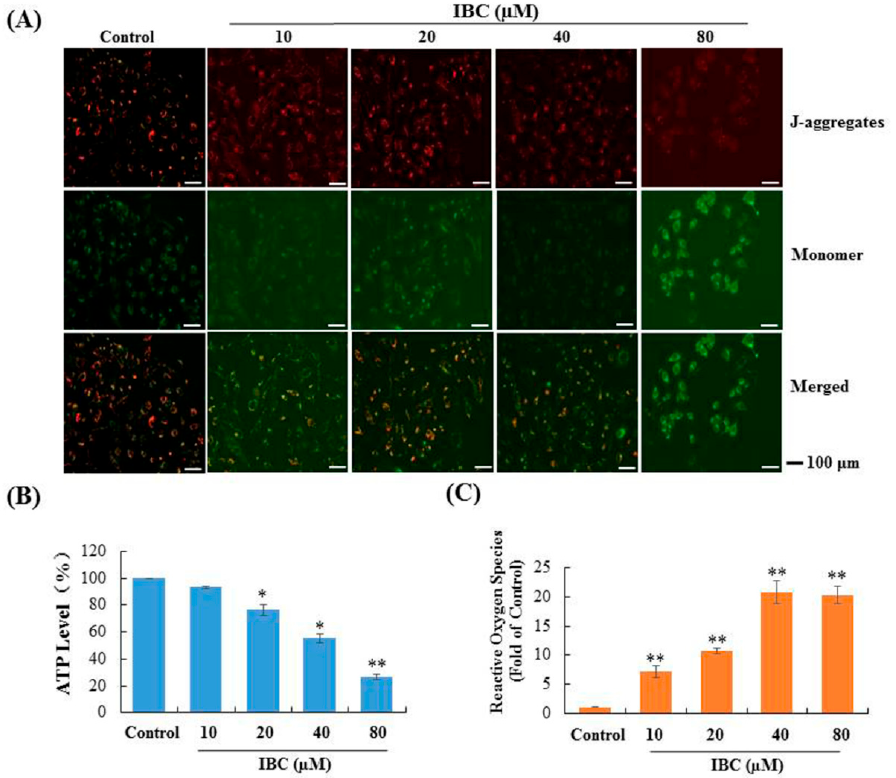
Figure 9. Effect of IBC on mitochondrial function in MDA-MB-231 cells. ( A ) Mitochondrial membrane potential was assessed by JC-1 staining and fluorescence microscopy. ( B ) Cellular ATP levels after treatment with various concentrations of IBC for 3 h. ( C ) IBC induced cellular ROS accumulation. * p < 0.05, ** p < 0.01 compared with the control.